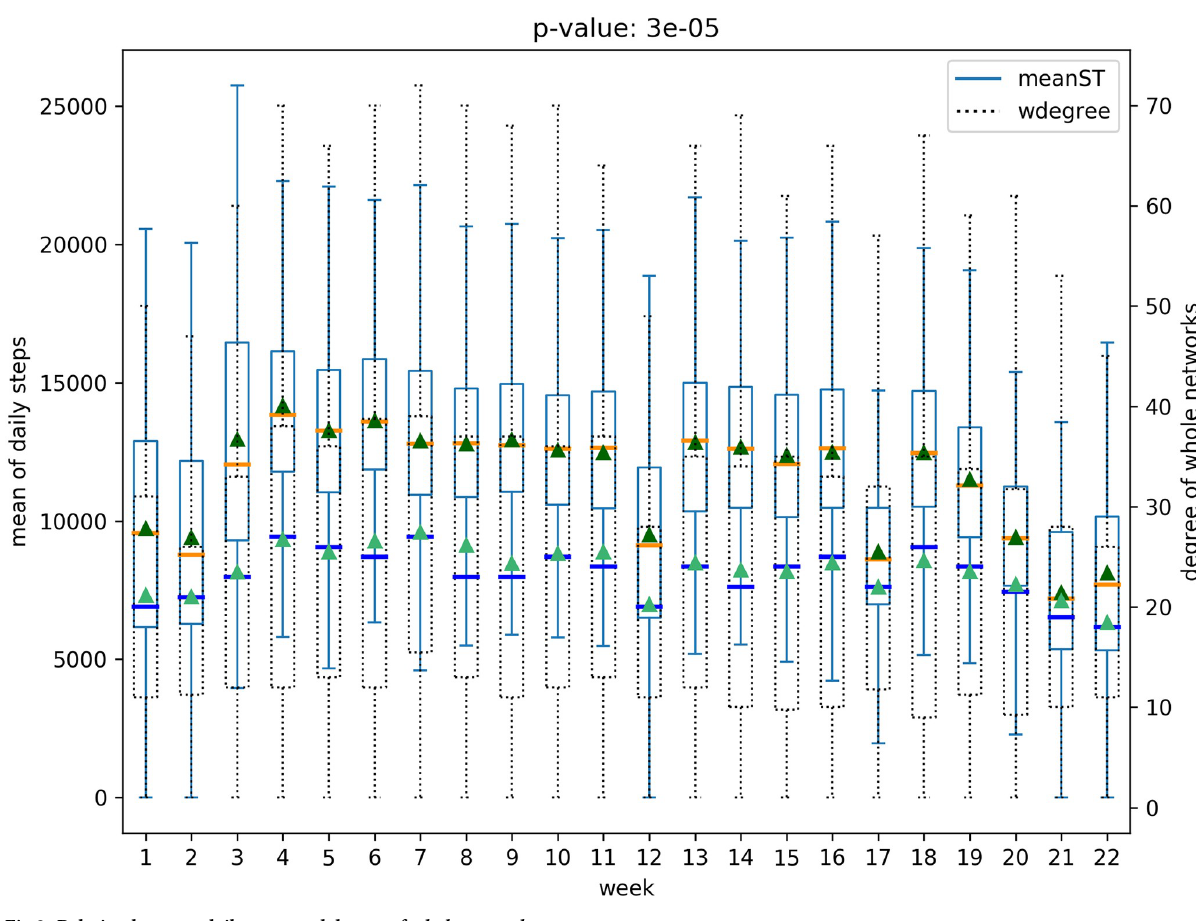
Fig 8. Relation between daily steps and degree of whole network .